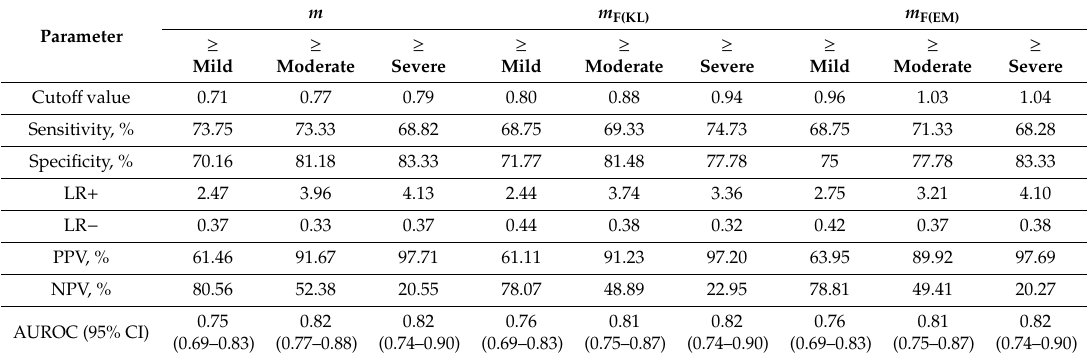
Table 2. Comparisons of ROC analysis for using DND imaging to diagnose di ff erent grades of hepatic